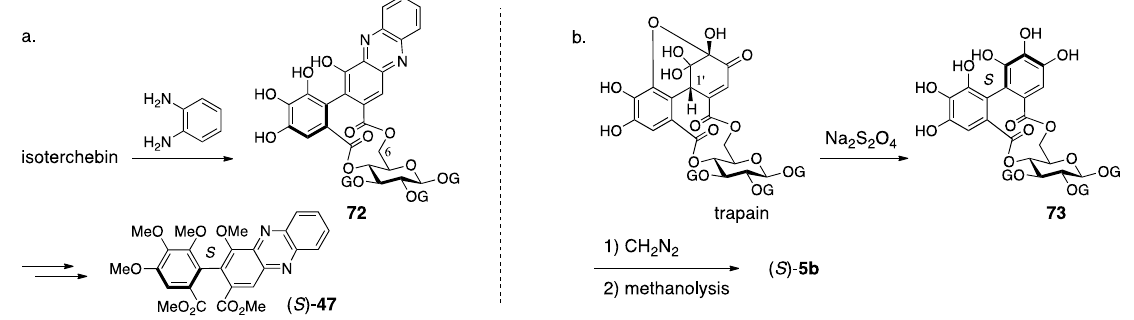
Figure 29. ( a ) The determination of the stereochemistry of the DHHDP group of isoterchebin ( 66 ) and ( b ) the reduction of trapain, which is the same compound with isoterchebin. ( b ) the reduction of trapain, which is the same compound with